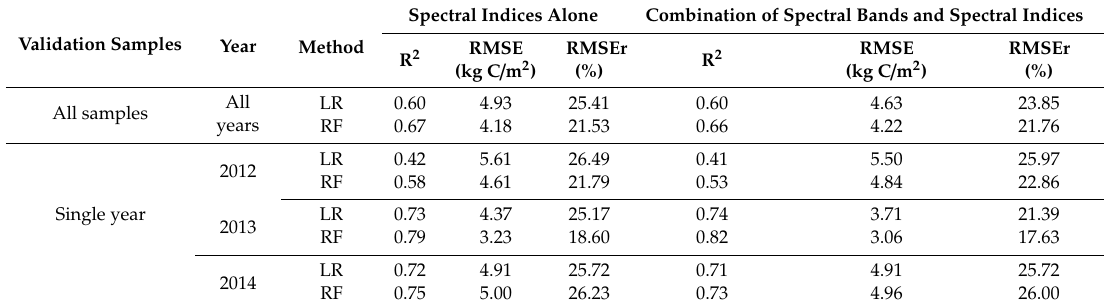
Table 6. Evaluation of modeling results using linear regression and random forest algorithms based on spectral indices or a combination of spectral indices and